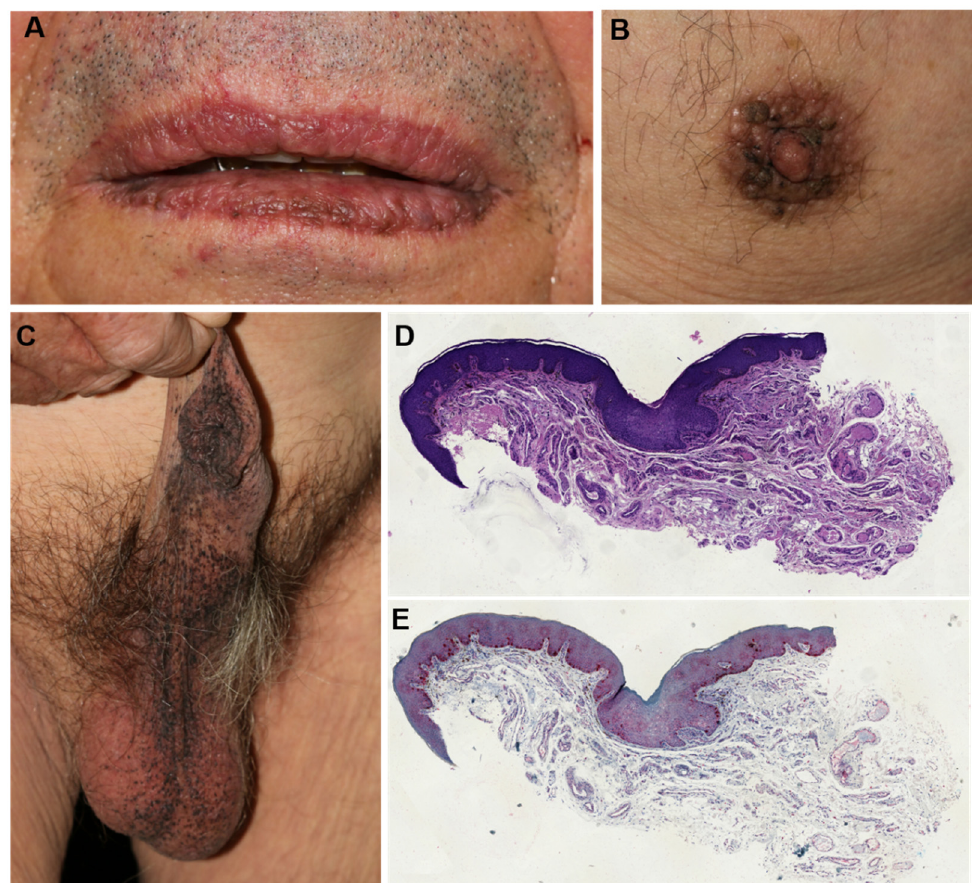
Figure 2. Dermatological examination and histopathological findings. Dermal and mucosal pigmentations of the ( A ): mouth, ( B ): nipple–areola, ( C ): penis and scrotum. ( D ): Hematoxylin and eosin stain of a lip biopsy shows acanthotic epithelium with basal hyperpigmentation and focally increased melanophages in the superficial dermis (medium magnification). ( E ): Immunohistochemical stain with Melan-A reveals junctionally regularly distributed melanocytes that are enlarged but not ascending (medium magnification).